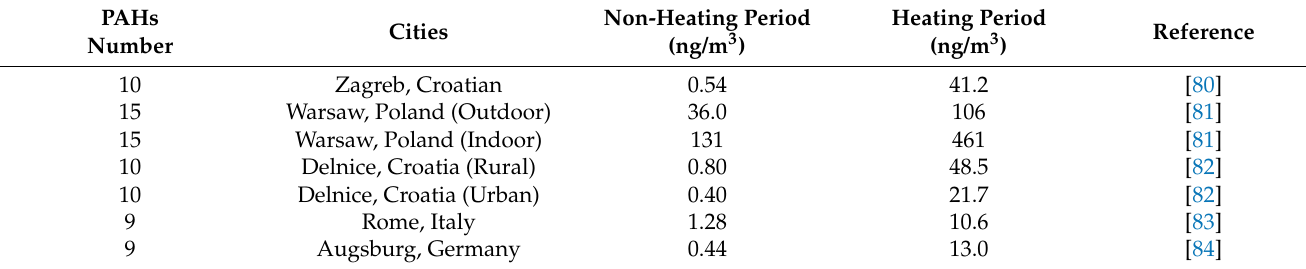
Table 5. Comparison of PAHs concentration in the non-heating period with heating